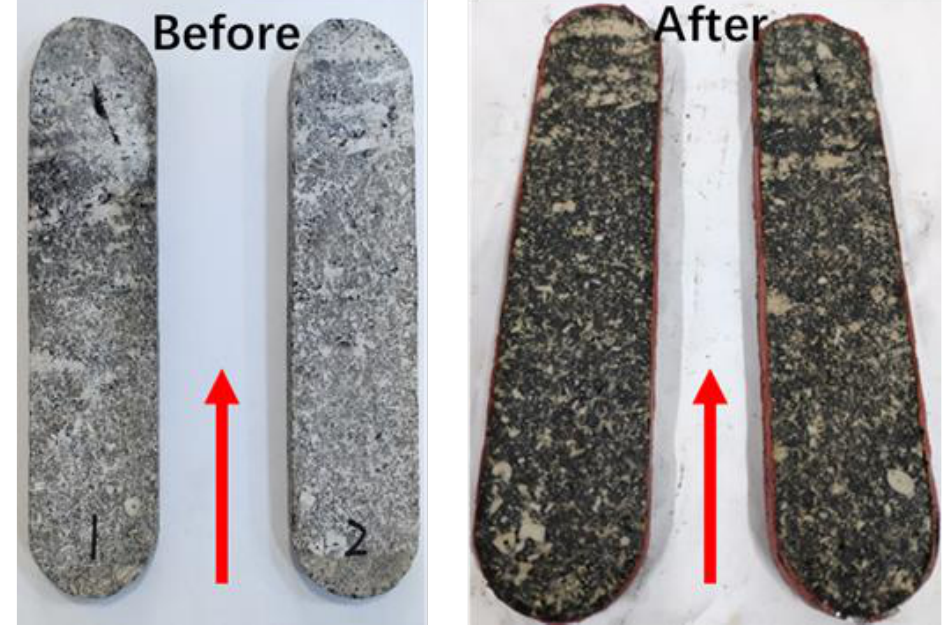
Figure 8. Photos of the first group of rock slabs before and after reaction.